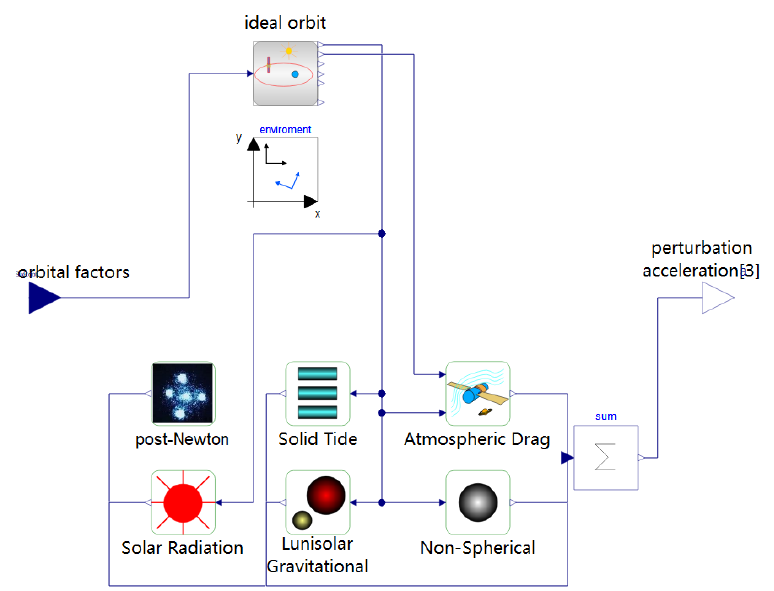
Figure 3. Orbit perturbation